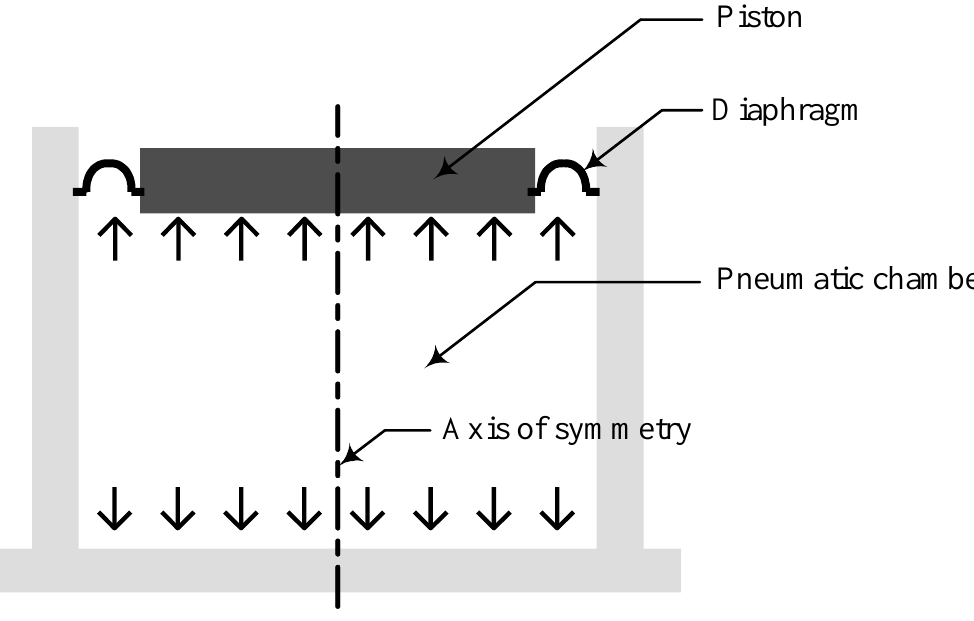
Figure 1. Schematic of the pneumatic spring.